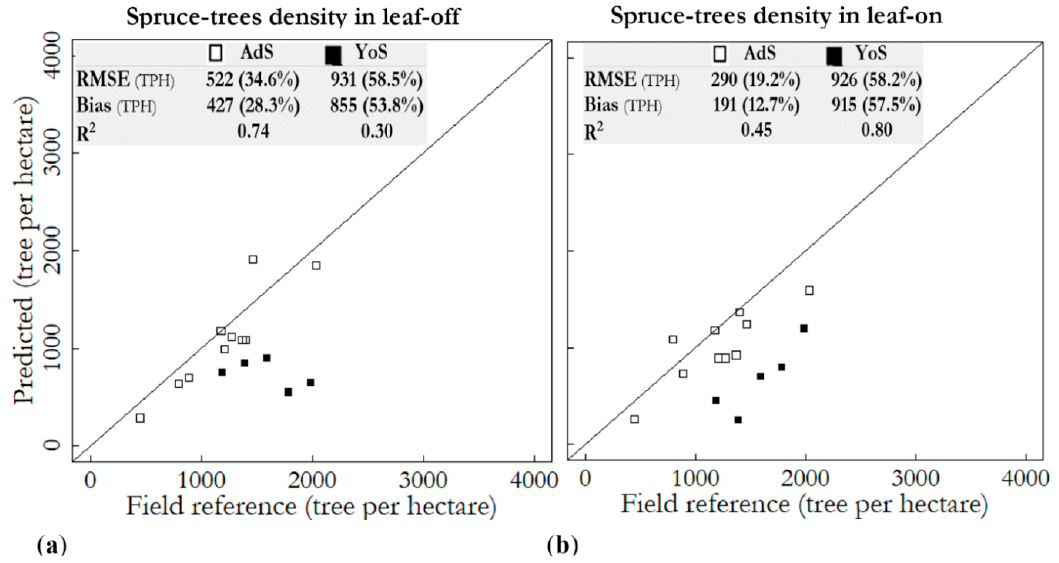
Figure 4. Spruce tree density (TPH) in leaf-off ( a) and leaf-on ( b ) conditions, separating plots in advanced seedling stand (AdS) and plots in young seedling stand (YoS) in leaf-off and leaf-on conditions.